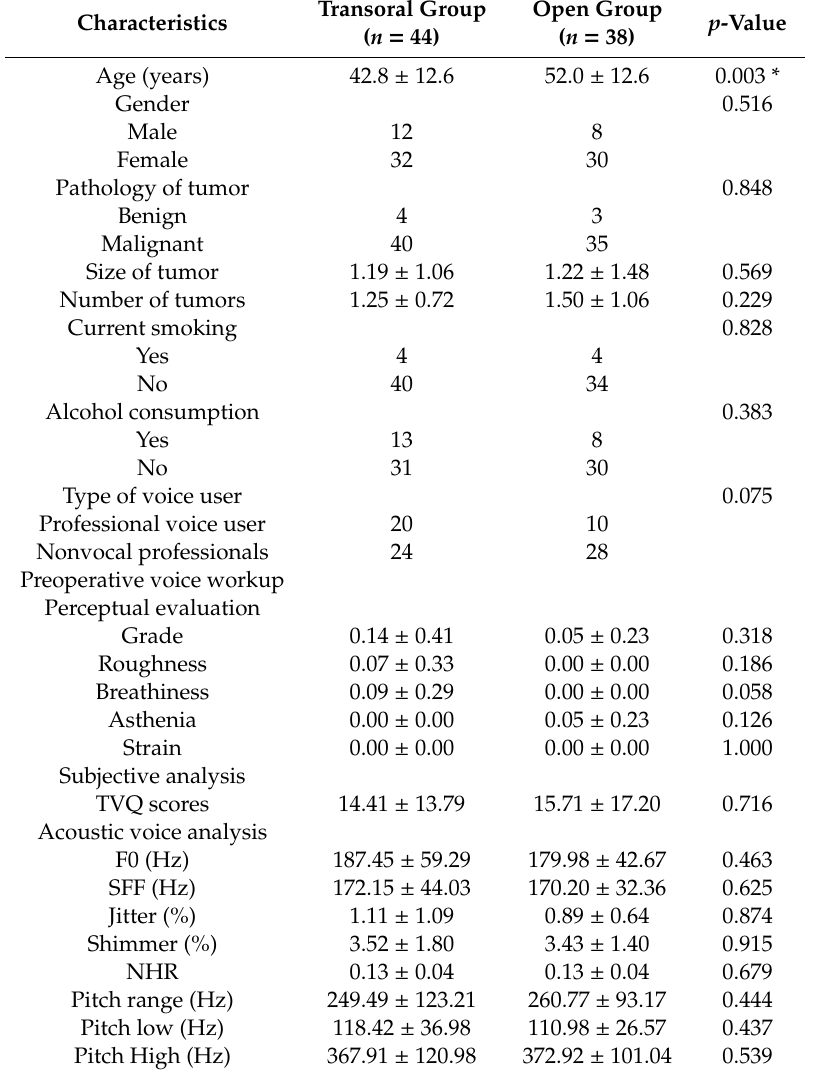
Table 1. Clinical characteristics of the patients in both